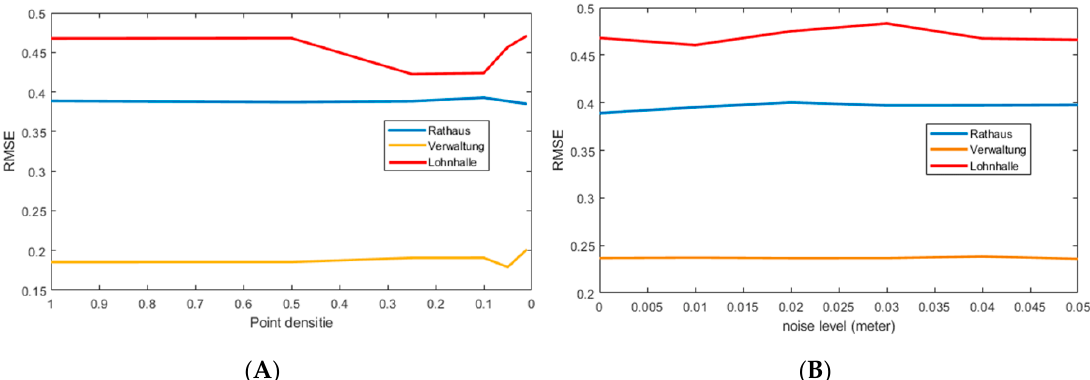
Figure 10. Robustness analysis of the proposed method. In figure ( A ), we randomly down-sampled the façade point clouds of the Rathaus, Verwaltung, and Lohnhalle data from their original point densities to various reduced densities in order to estimate the robustness to point density. In figure ( B ), we added Gaussian noise with different standard deviations (1, 2, 3, 4, and 5 cm) to the point cloud data to estimate the robustness to noise.